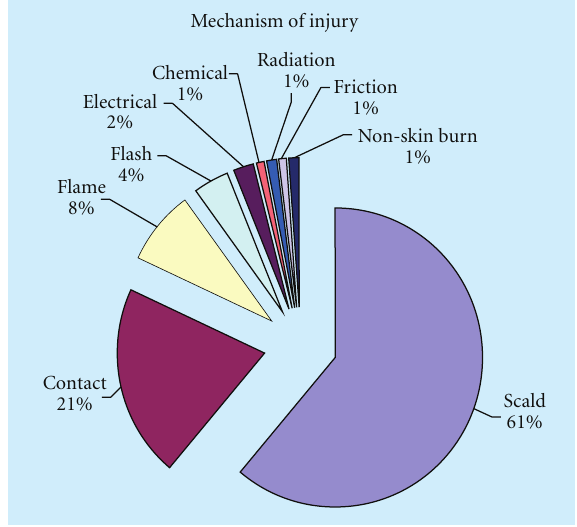
Figure 1: Illustration of various burn aetiologies. Note that scalds in children account for more than 60% of all burn injuries.